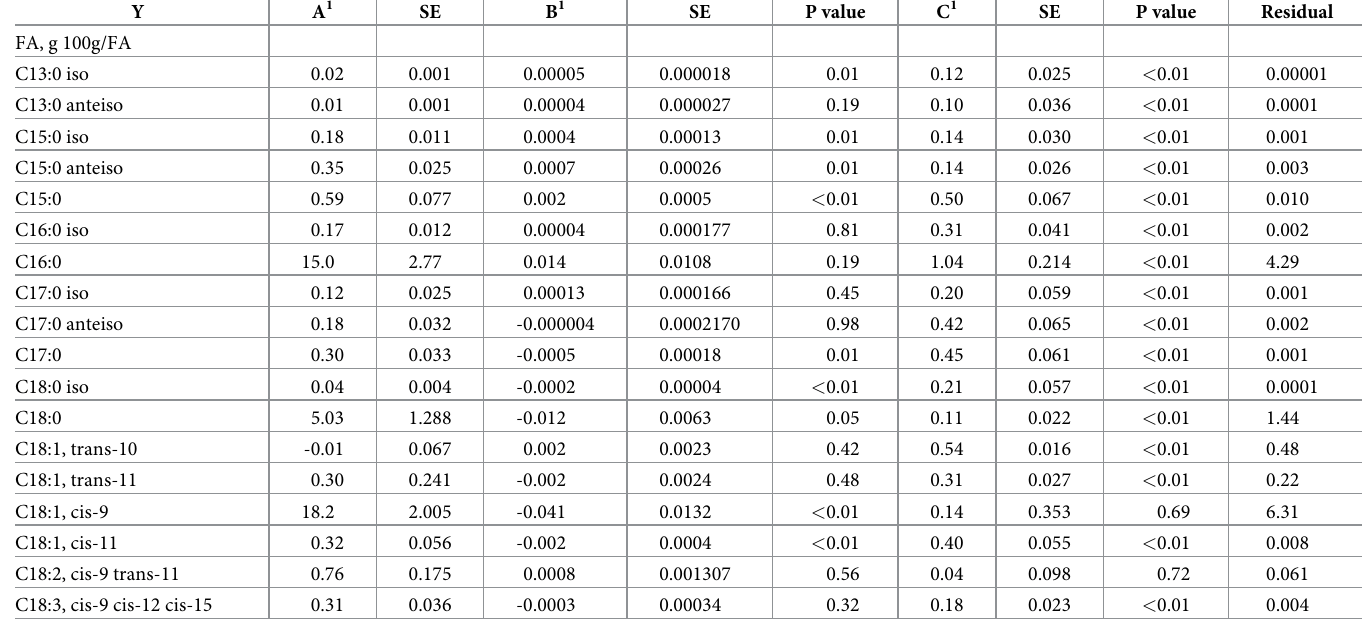
Table 7. Influence of energy balance and composition of omasal fatty acids (FA) on milk FA concentration estimated by multivariate mixed model regression analy- sis (Milk FA = A + BX 1 + CX 2 ) in dairy cows.